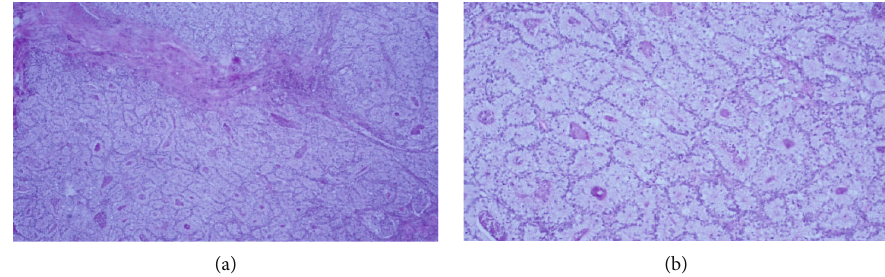
Figure 3: Microscopic appearance of the clear cell component in the tumor: (a) 40 × ; (b) 100 ×